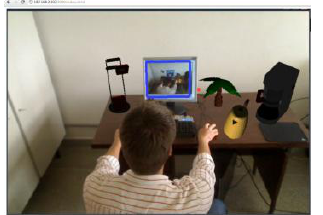
Figure 6. User selecting objects from the web to the physical world